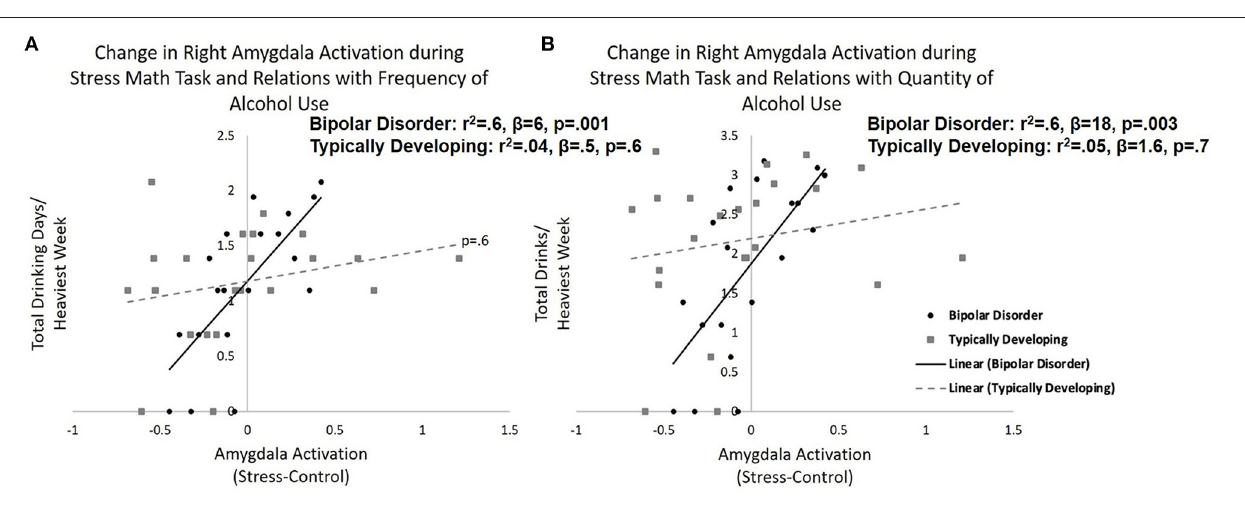
FIGURE 2 | Amygdala reactivity to acute psychosocial stress and relations with recent alcohol use. Relations between right amygdala reactivity to acute psychosocial stress [stress condition minus control condition during stress math task (SMT)] in typically developing young adults and young adults with bipolar disorder and recent (A) frequency (total drinking days during heaviest drinking week) and (B) quantity (total drinks during heaviest drinking week) of alcohol use. Specifically, greater right amygdala reactivity to acute stress correlated with greater frequency ( p = 0.001) and quantity ( p = 0.003) of alcohol use in young adults with bipolar disorder.